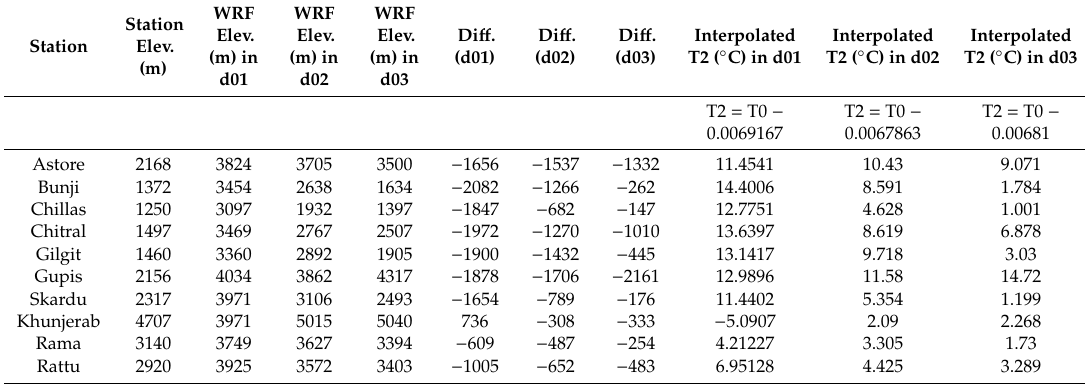
Table 6. Stations and the interpolated 2 m air temperature (T2) with lapse rate correction at an annual time